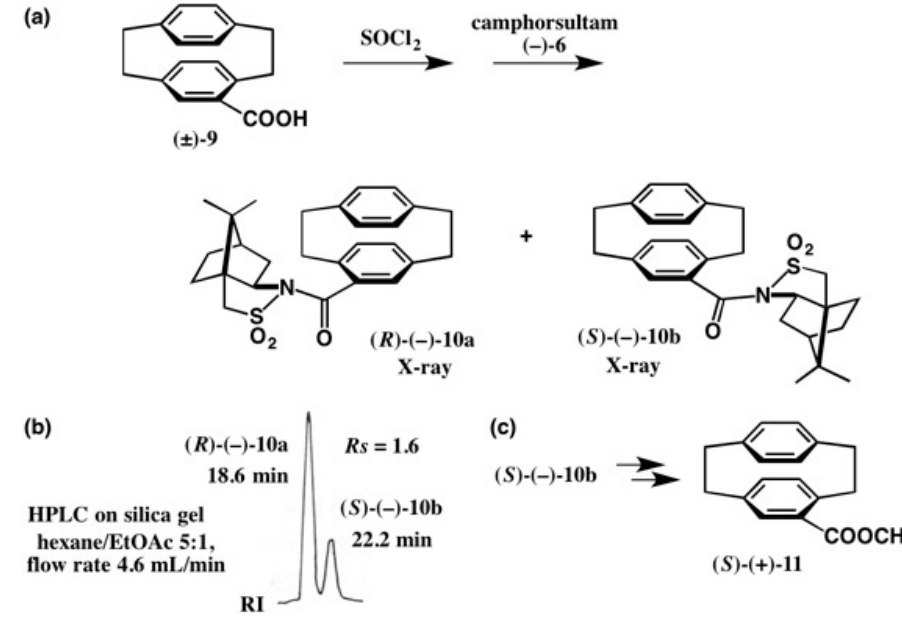
Figure 9. Preparation of diastereomeric amides 10a and 10b ( a ), separation by HPLC on silica gel ( b ), and preparation of ester ( S )-(+)- 11 ( c ). HPLC, redrawn from [24].